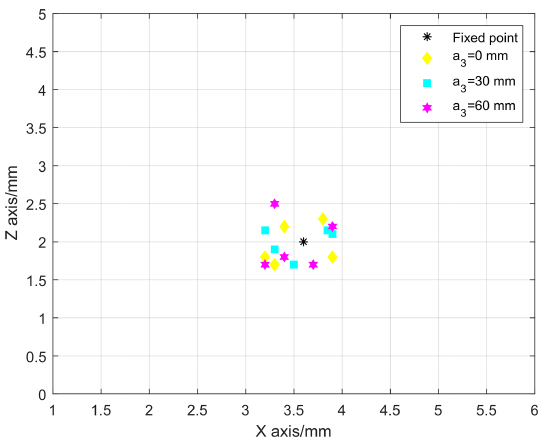
Figure 16. The error measurement data distribution diagram of the pitch angle’s remote center